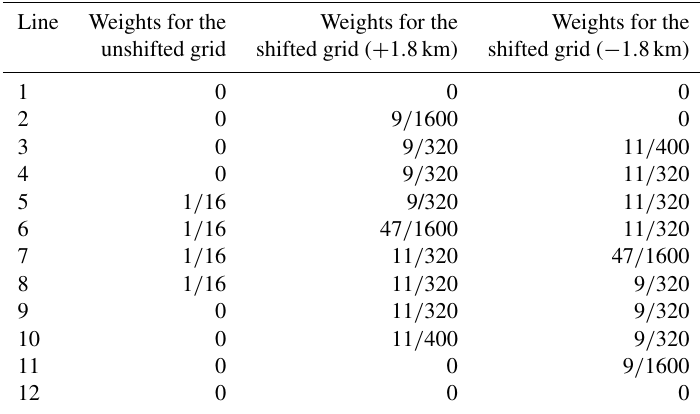
Table 3. Contribution of SGLI pixels to shifted and unshifted averaging grids for a single 3MI pixel. These weights include the effects of the satellite’s along-track motion and the interpolation. Line Weights for the Weights for